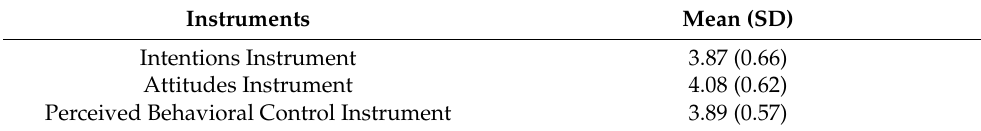
Table 3. Descriptive statistics for